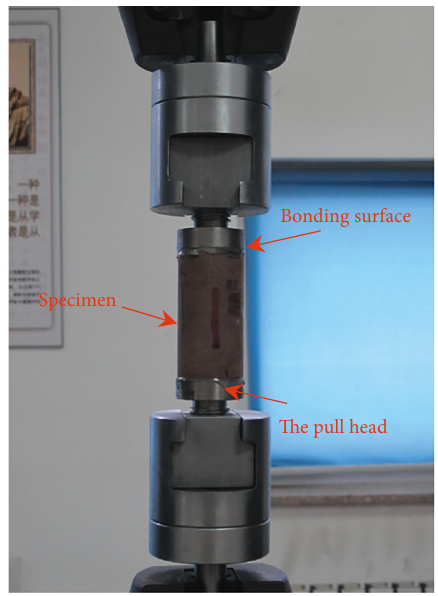
Figure 2: Direct tension test